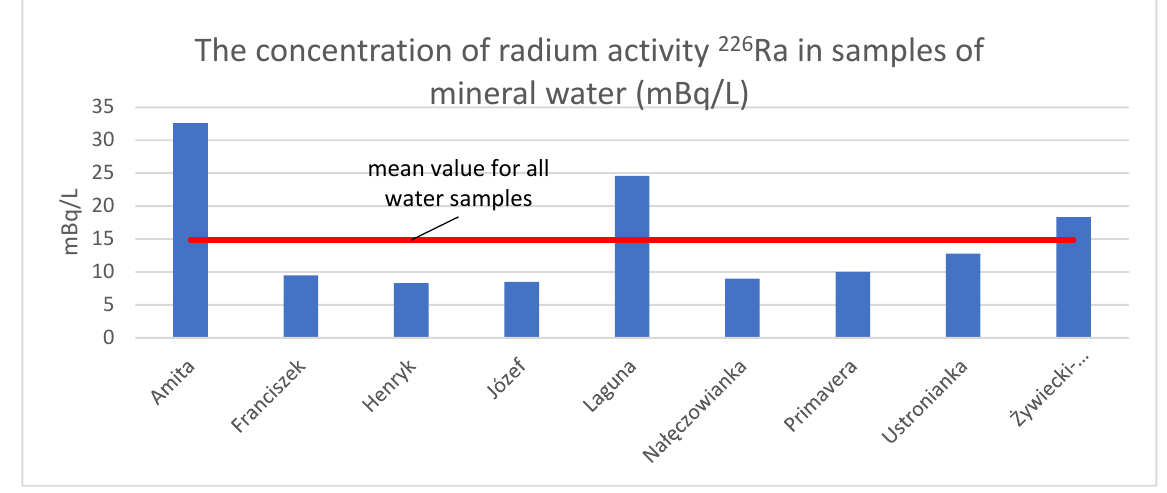
Figure 2. Concentrations of radium 226 Ra activity in 9 samples of mineral waters. The red line represents the mean value for the set of samples.